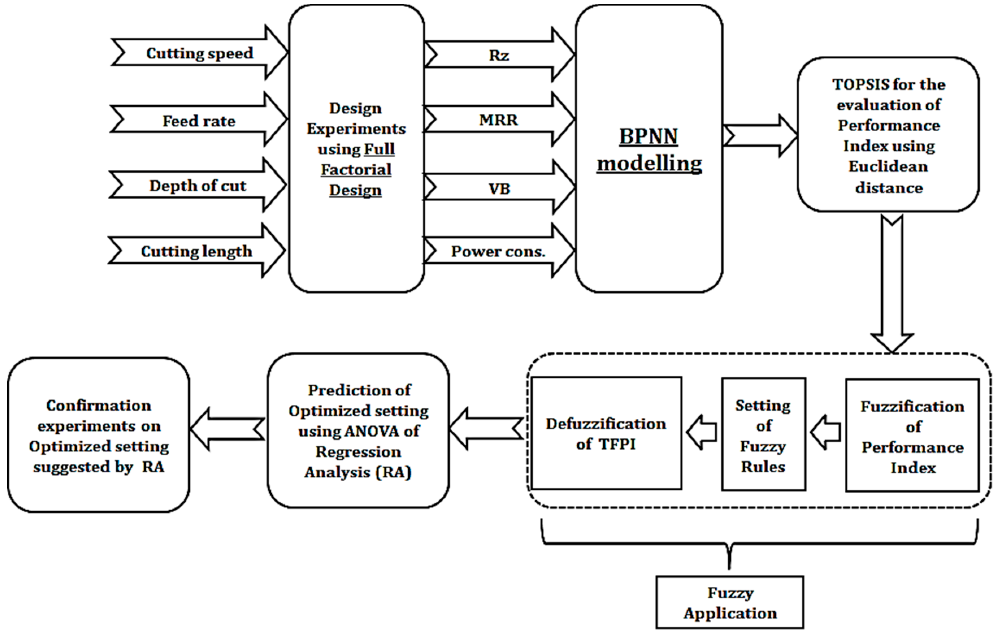
Figure 2. The overall methodology for modeling and optimization when high ‐ speed machining Ti ‐ 6Al ‐ 4v.